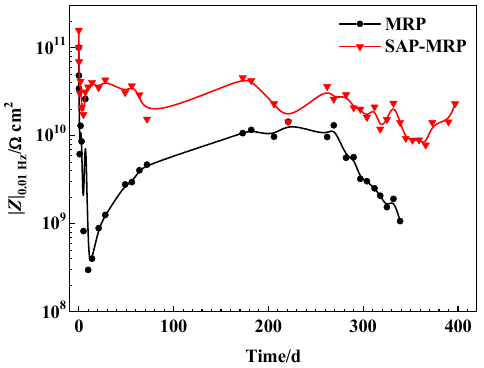
Figure 4. The variations of | Z | 0.01 Hz values with immersion time in the simulated acid rain solution.